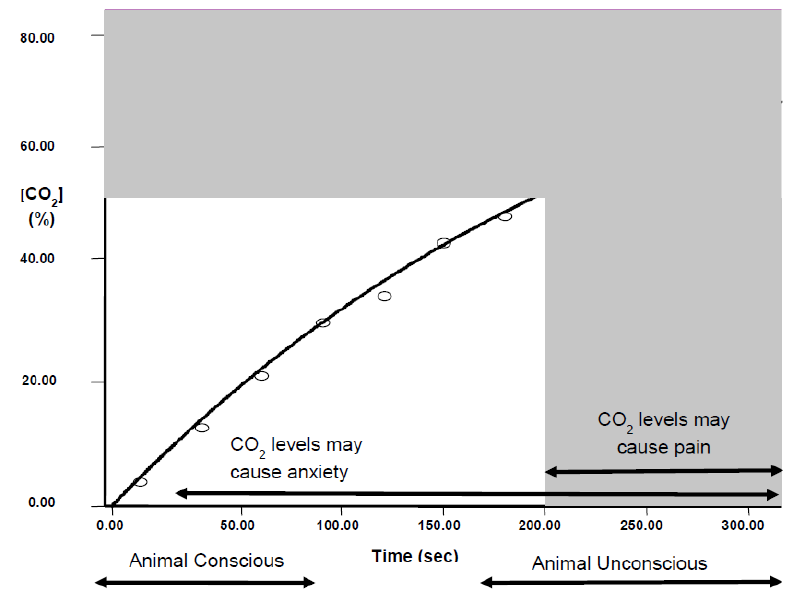
Figure 4. The induction of loss of consciousness during 20% per minute filling with CO 2 . Time line for loss of consciousness in rats exposed to CO 2 at 20% chamber volume per minute. Animals lose consciousness after approximately 156 s. Bars below the x-axis indicate periods where the animals would be conscious or unconscious. Shaded area shows the likely time/concentration where CO 2 could cause pain (which occurs after loss consciousness in this case). Levels above 5% may cause anxiety and include a significant duration where the animal would still be conscious.